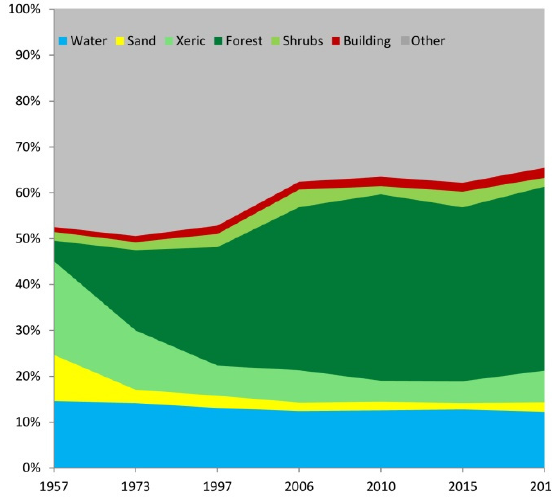
Figure 8. Land-cover change dynamics from 1957 to 2018 (1965 was excluded because of the low classification accuracy and the relatively higher GSD of CORONA imagery, which limited the possibility of shrub community identification).